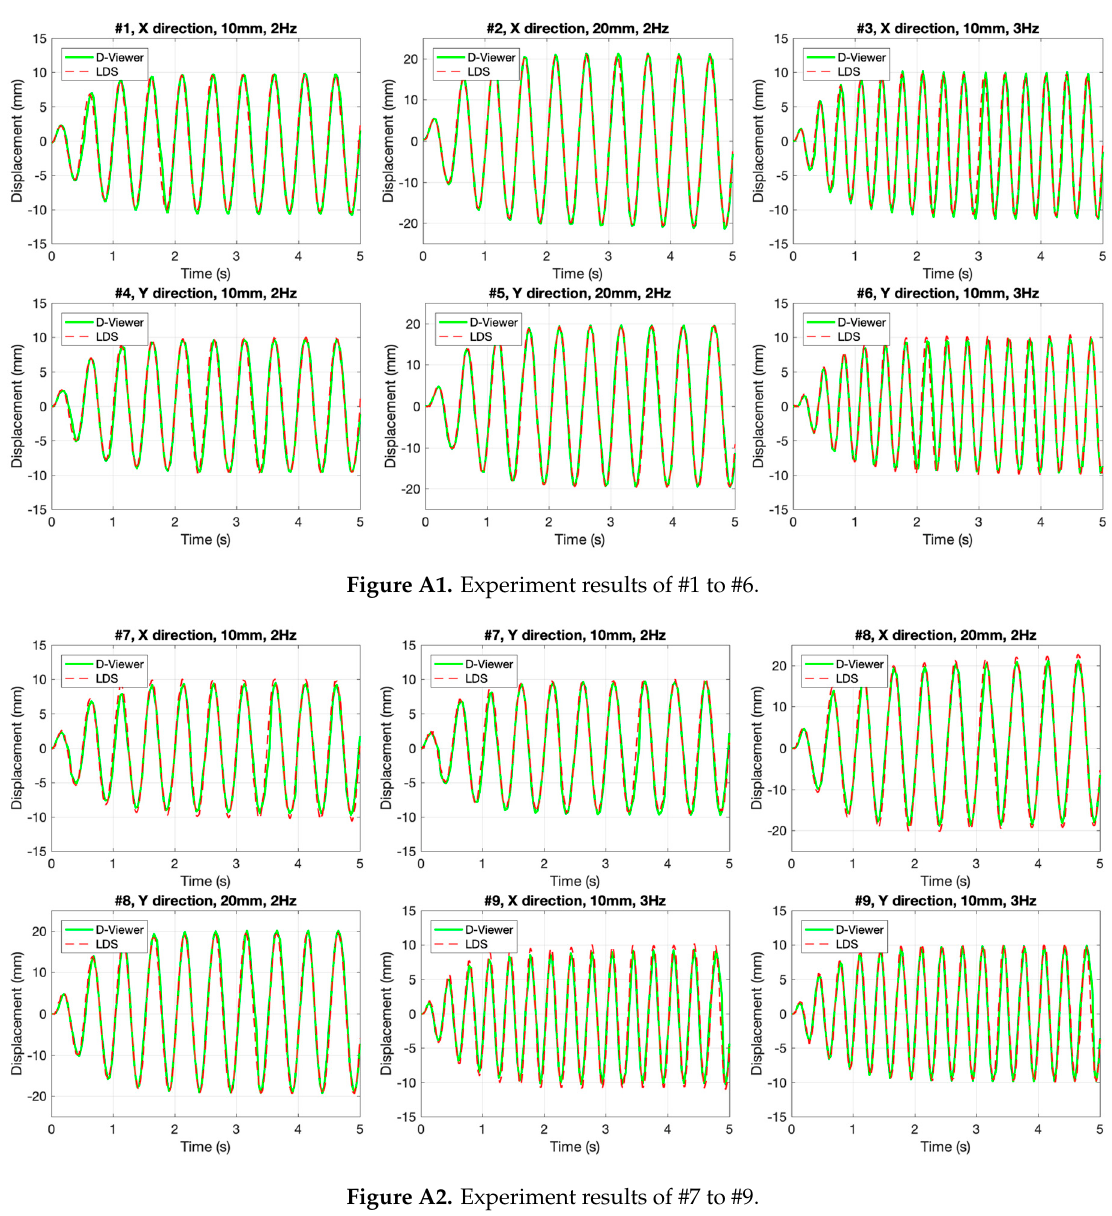
Figure A2. Experiment results of #7 to #9.